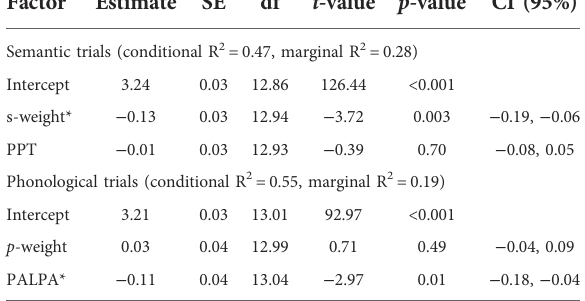
TABLE 6 Summary of WPVT phonological trial logistic mixed effect models. Factor